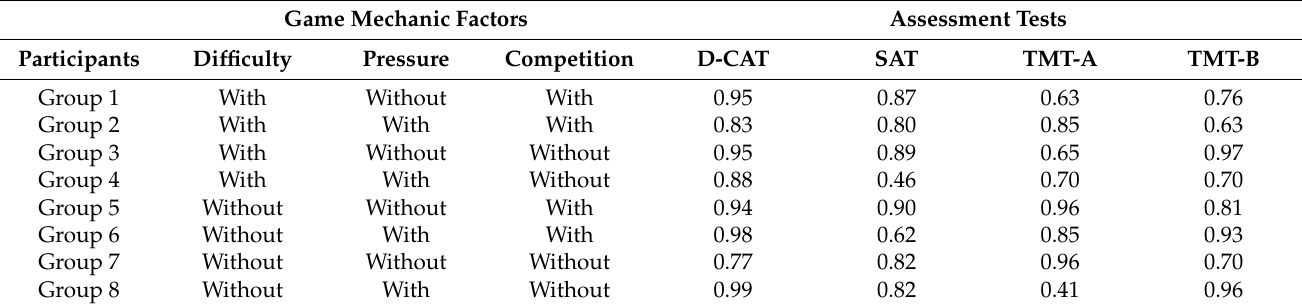
Table 26. Test–retest reliability (intraclass correlation